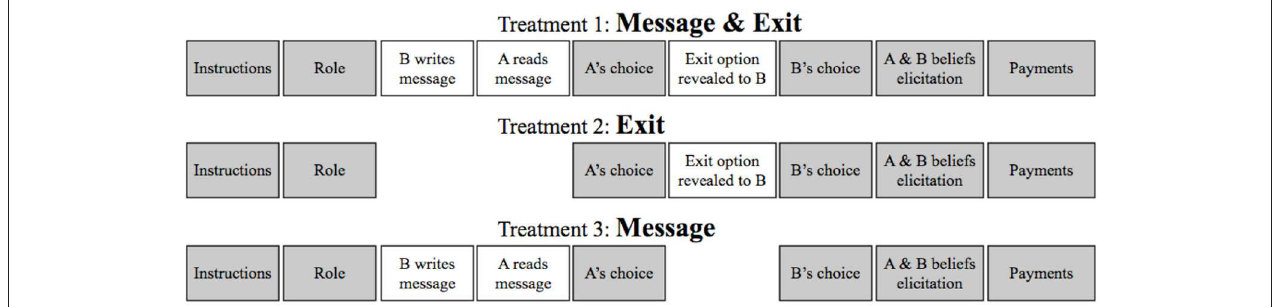
FIGURE 3 | Timeline of the three main treatments used in the experiment. The additional Message (C & D) treatment has all the same features of Message but without exposure (i.e., A is not informed about B’s actual choice).